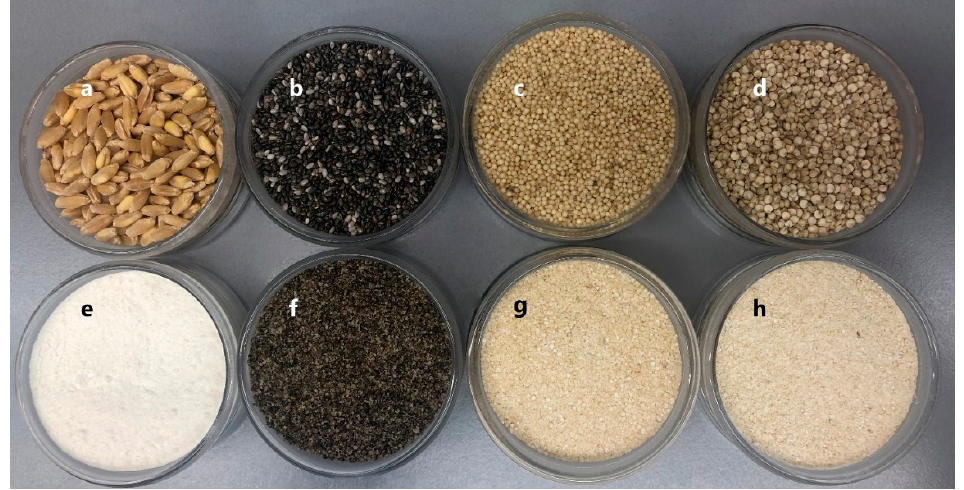
Figure 1. Raw materials: wheat grains ( a ); chia seeds ( b ); amaranth grains ( c ); quinoa grains ( d ); wheat flour ( e ); whole chia flour ( f ); whole amaranth flour ( g ); whole quinoa flour ( h ).